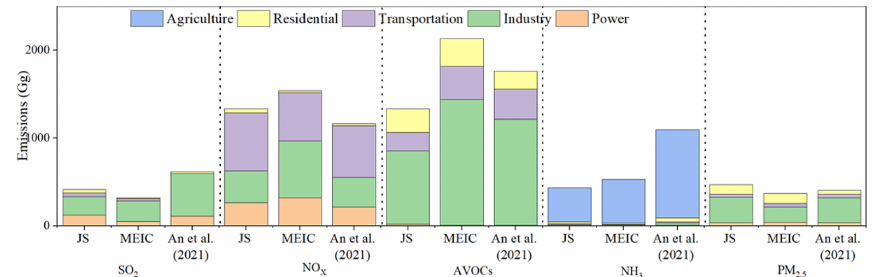
Figure 8. Comparison of Jiangsu emissions for 2017 with MEIC and An et al. (2021). The air pollutants from left to right are SO 2 , NO x , VOCs, NH 3 , and PM 2 . 5 ,